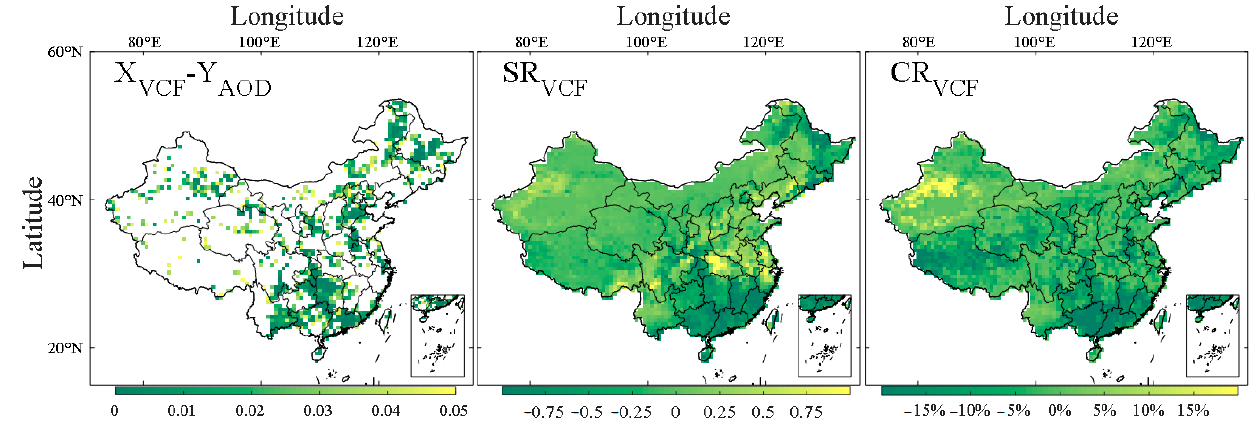
Figure 12. Results of the Granger causality test, SR, and CR between AOD and VCF.